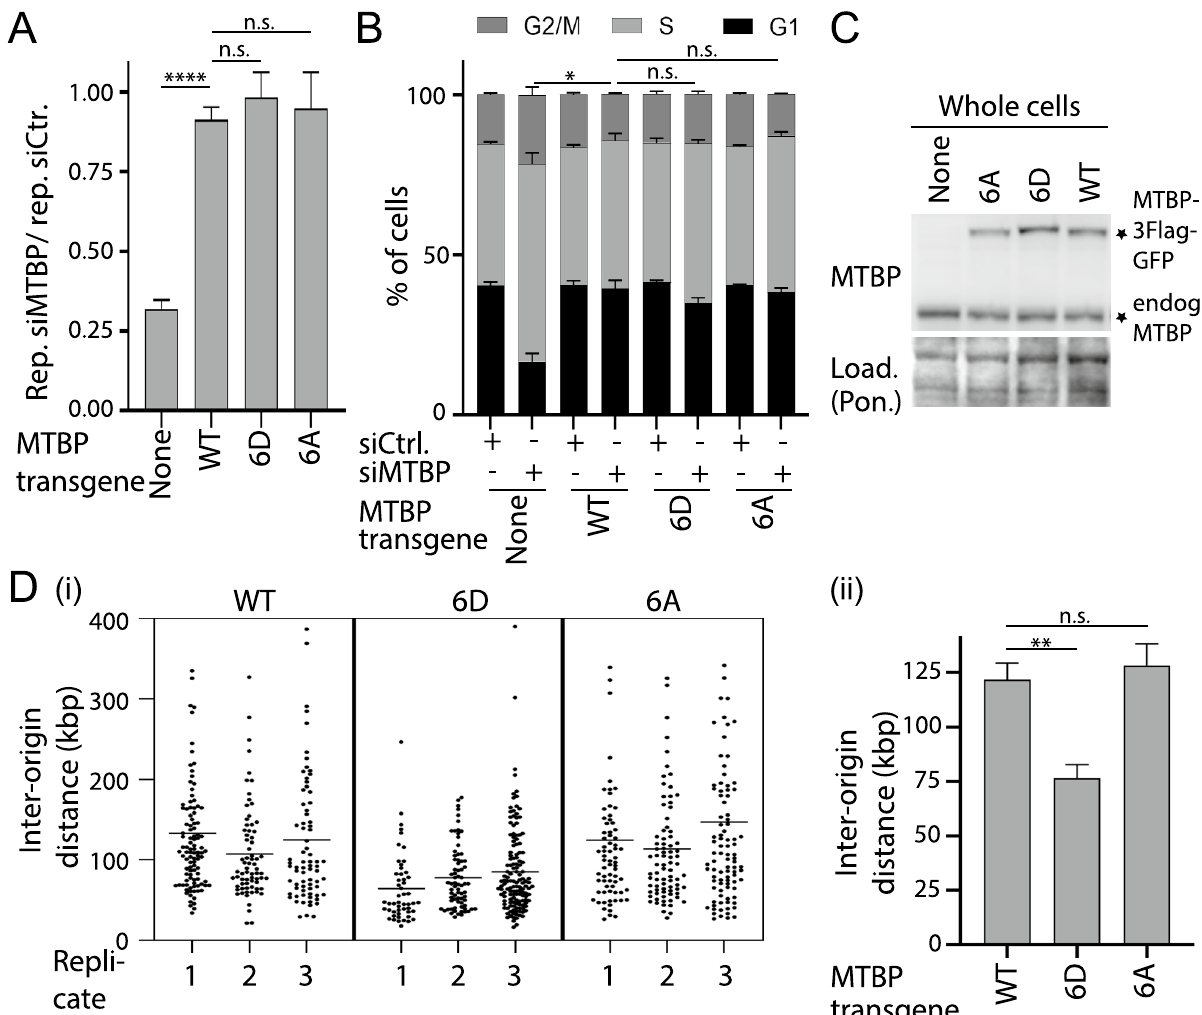
Figure 6. Phosphorylation of MTBP on CDK consensus sites promotes origin firing in unperturbed growth conditions. ( A , B ) Quantification of replication activity ( A ) or cell cycle distribution ( B ) using BrdU-flow cytometry as described in 2D/E of indicated HeLa Flip-In T-Rex cell lines. Error bars, SEM. n = 3; MTBP mutants: MTBP-6A/D, see 5C. Significance tests as in 2D/E. ( C ) Whole cell lysates of stable cell lines described in A were analysed by immunoblotting using anti-MTBP (12H7), and Ponceau (Pon.) staining. ( D ) Inter-origin distance of cells as described in A measured by DNA combing as described in 4C. See also Supplementary Information Fig.